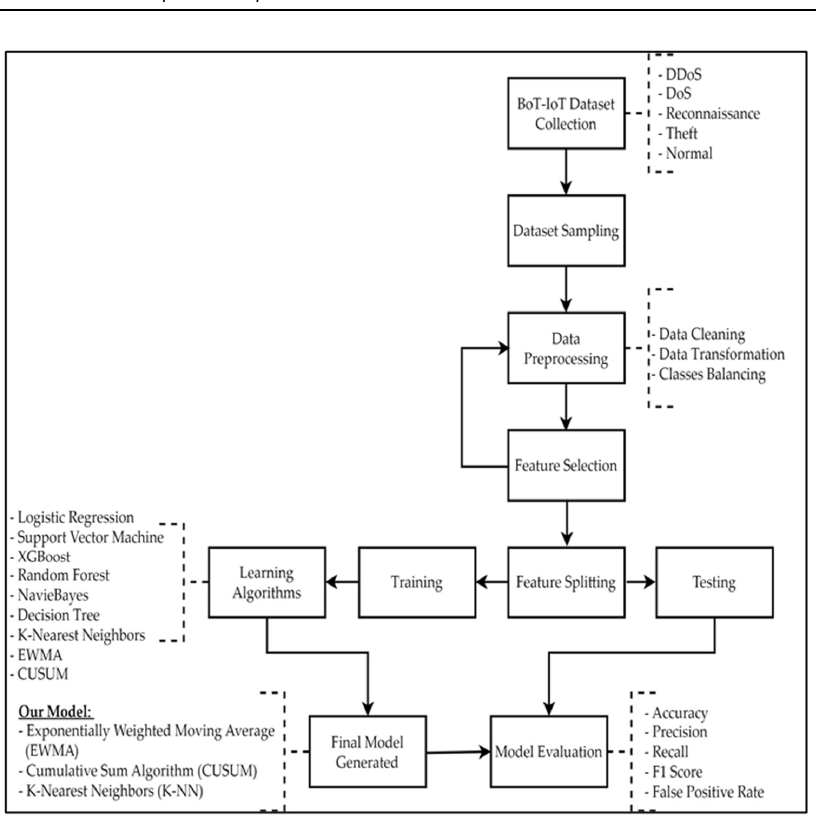
Figure 6. Complete attack and anomaly detection procedure.